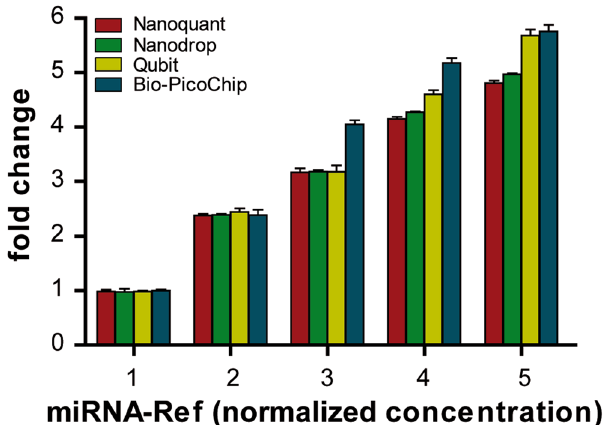
Figure 2. Quantification of miRNA-Ref samples at different normalized concentrations assessed by Nanoquant, Nanodrop, Qubit and Bio-PicoChip. Evaluation of the performance of the four quantification techniques in a series of five increasing miRNA-Ref concentrations prepared from the 10 ng/ μ L working solution. Data on the X axis are normalized to the lowest concentration (data in Supplementary Table S1). Values for all four platforms increased proportionally with increasing